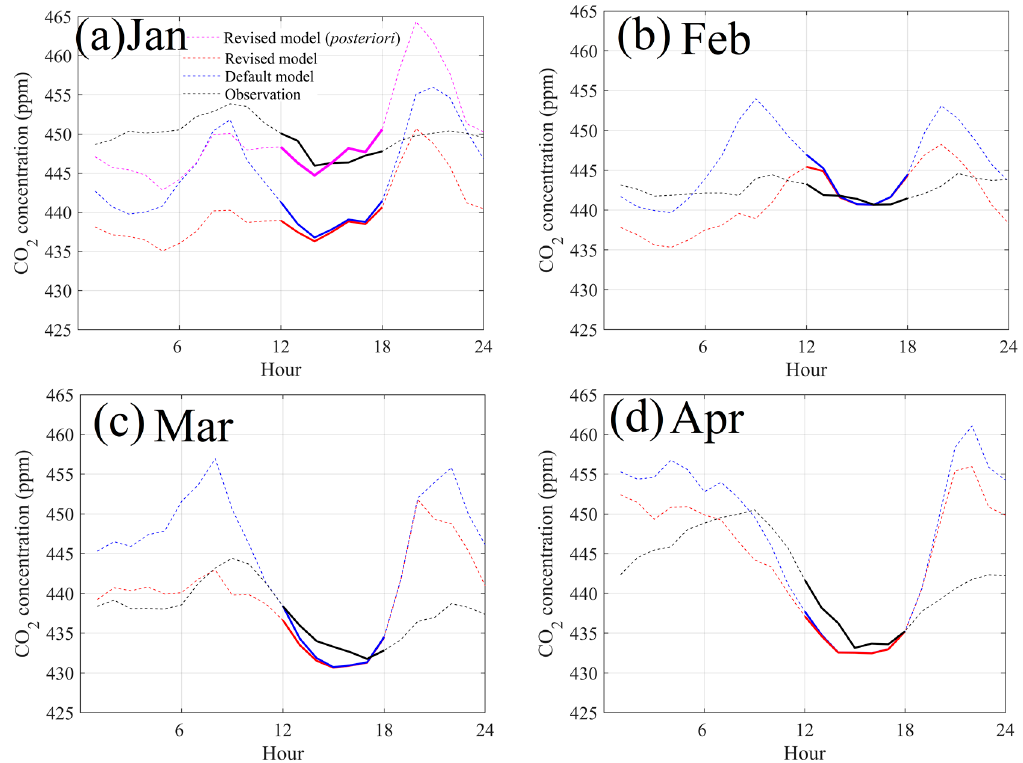
Figure 6. Monthly averaged diurnal variations of CO 2 concentrations comparisons in ( a ) January, ( b ) February, ( c ) March, and ( d ) April, the bold line represents daytime period (12:00–18:00, local time), “ posteriori ” in panel a indicates simulations using the posteriori emissions constrained by MSF